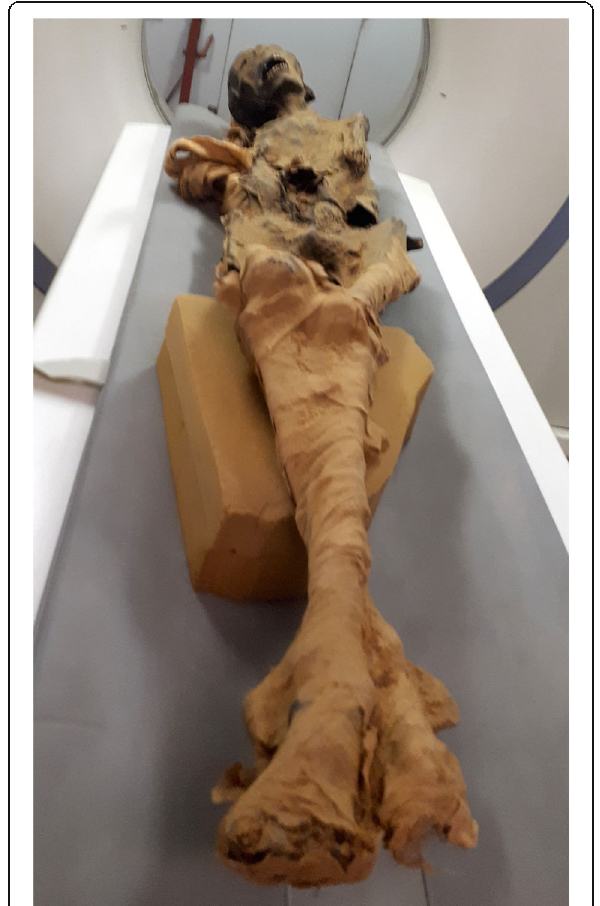
Fig. 2 Picture of the full body of “ Unknown-Woman-A. ” The picture was taken on March 9th, 2020. The mummy has an odd posture with crossed legs at the ankles is evident